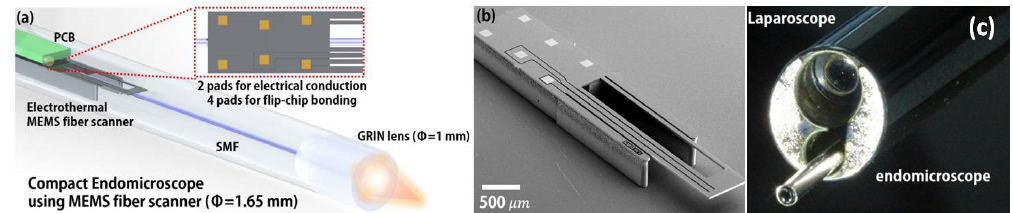
Figure 9. Electrothermal MEMS fiber scanner-based confocal microendoscope. ( a ) Schematic drawing of the catheter with a Lissajous scanner. The MEMS fiber scanner is fabricated for flip-chip bonding, which minimized the electrical packaging dimensions, resulting in the scanner package being 1.65 mm in diameter. ( b ) Top-view SEM image of the fabricated microactuator. The footprint dimension indicates 1 mm × 5 mm × 0.43 mm; ( c ) Photograph of the packaged catheter assembled to the laparoscopic functional channel. Reproduced with permission from [54]; published by OSA, 2018.